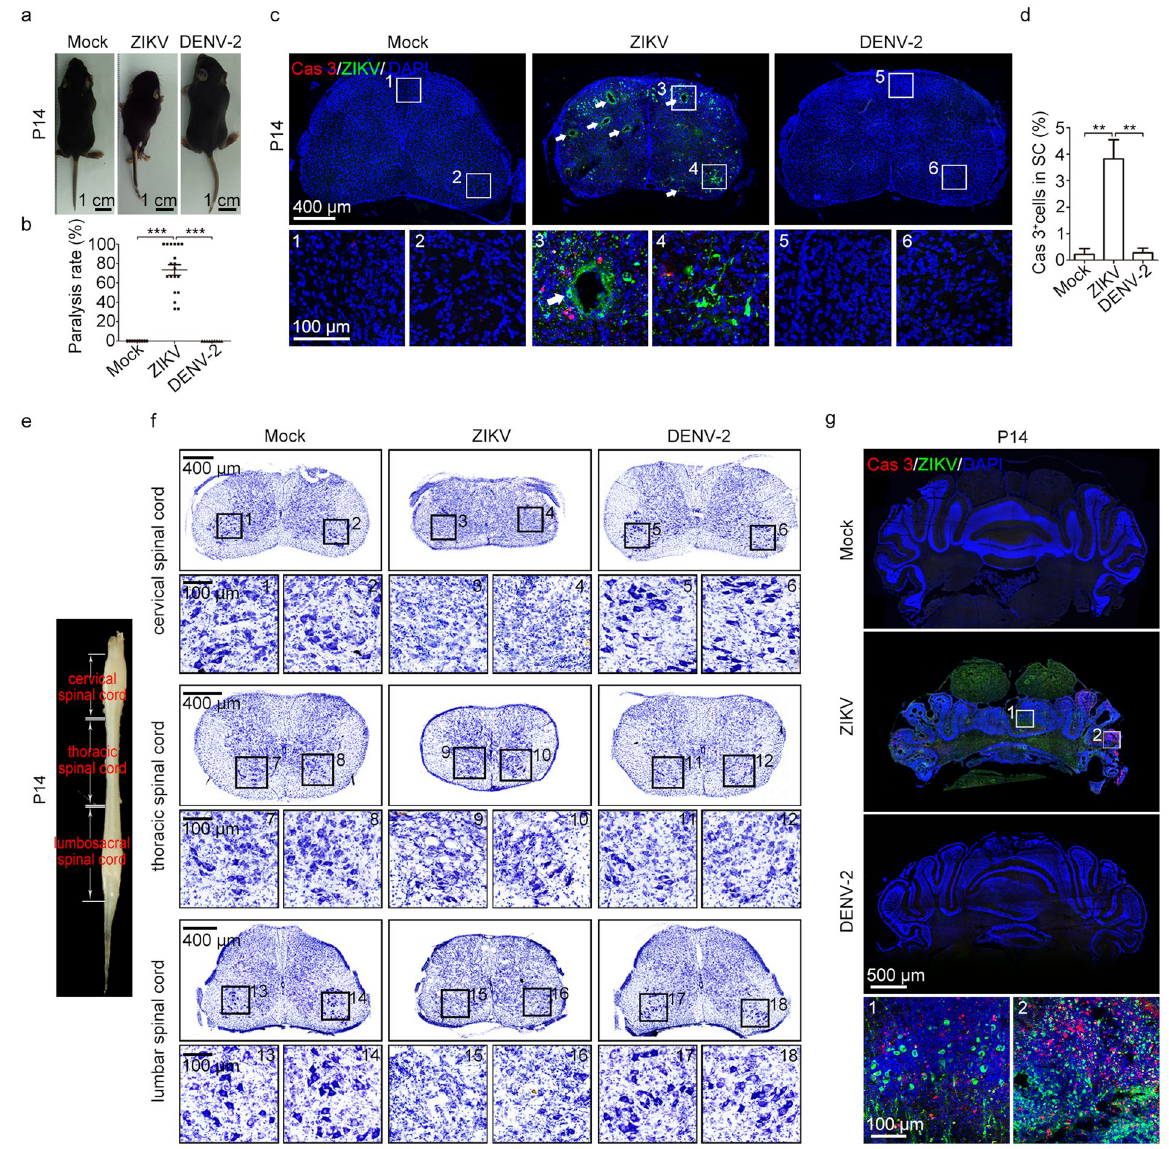
Figure 5. Severe movement defects were induced by maternal ZIKV infection. (a) Representative images of P14 offspring mice. The hind limbs of ZIKV-infected mice were paralyzed. (b) Quantification of the paralysis rate during P0-P28. (c) Representative images of lumbar spinal cords stained for Cas3 and ZIKV. White arrows, cavities. (d) Percentage of Cas3-positive cells within lumbar spinal cords. n Mock = 4, n ZIKV = 8, n DENV-2 = 4 samples from three independent experiments. (e) Representative image of a P14 spinal cord to illustrate the different segments. (f) Nissl staining of P14 cervical, thoracic, and lumbar spinal cord. (g) Representative images of the cerebellum stained for Cas3 and ZIKV. Quantification data are presented as the mean ± SEM. One-way ANOVA with Bonferroni’s post hoc test, ** p < 0.01, *** p <